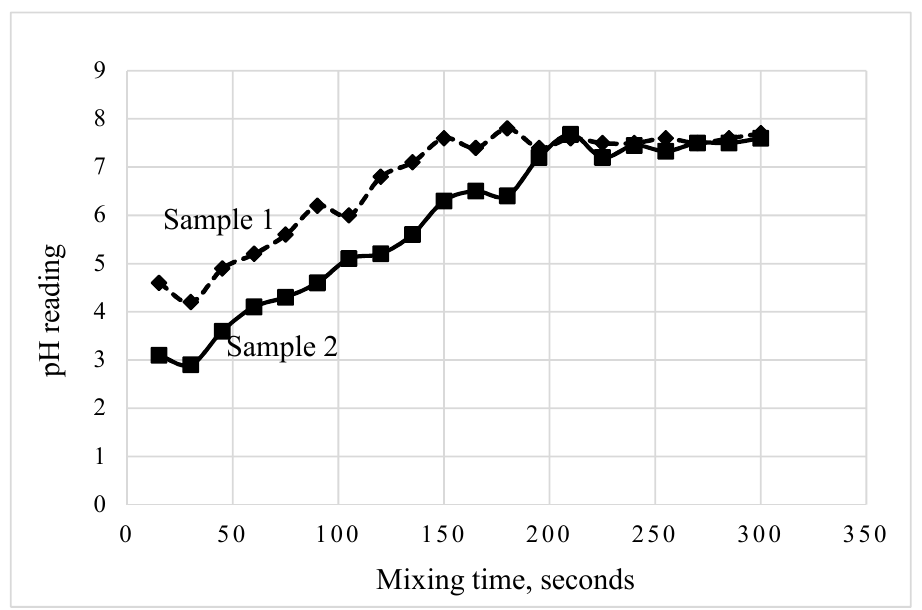
Figure 6. Sample result for mixing time vs pH measurement in the improved neutralization setup.